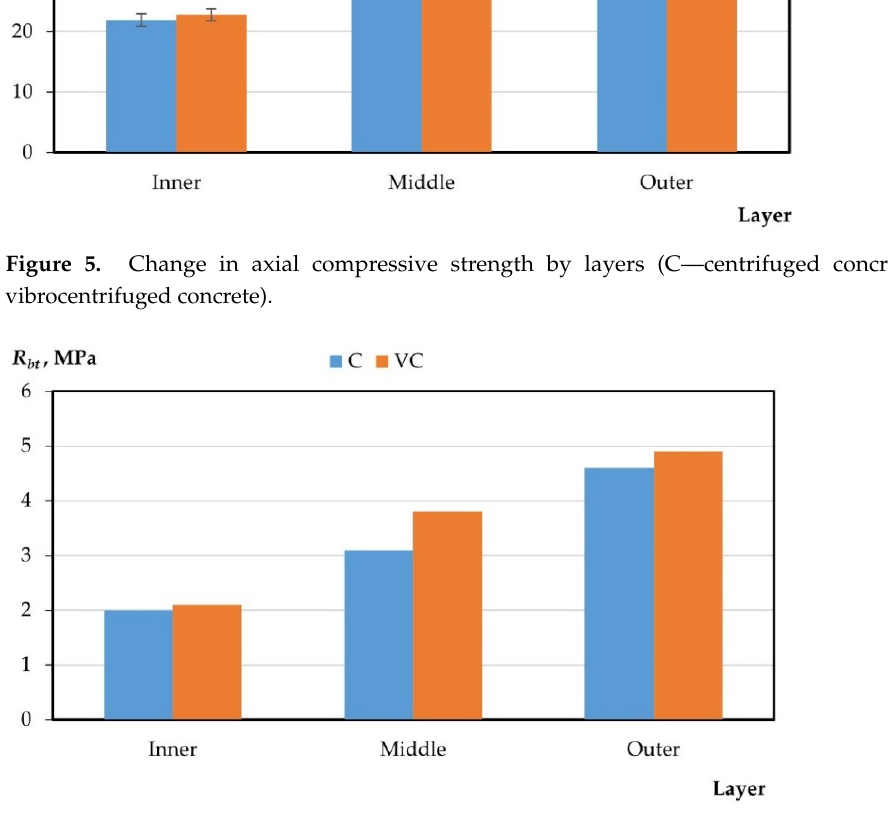
Figure 6. Change in axial tensile strength by layers (C—centrifuged concrete, VC—vibrocentrifuged concrete).